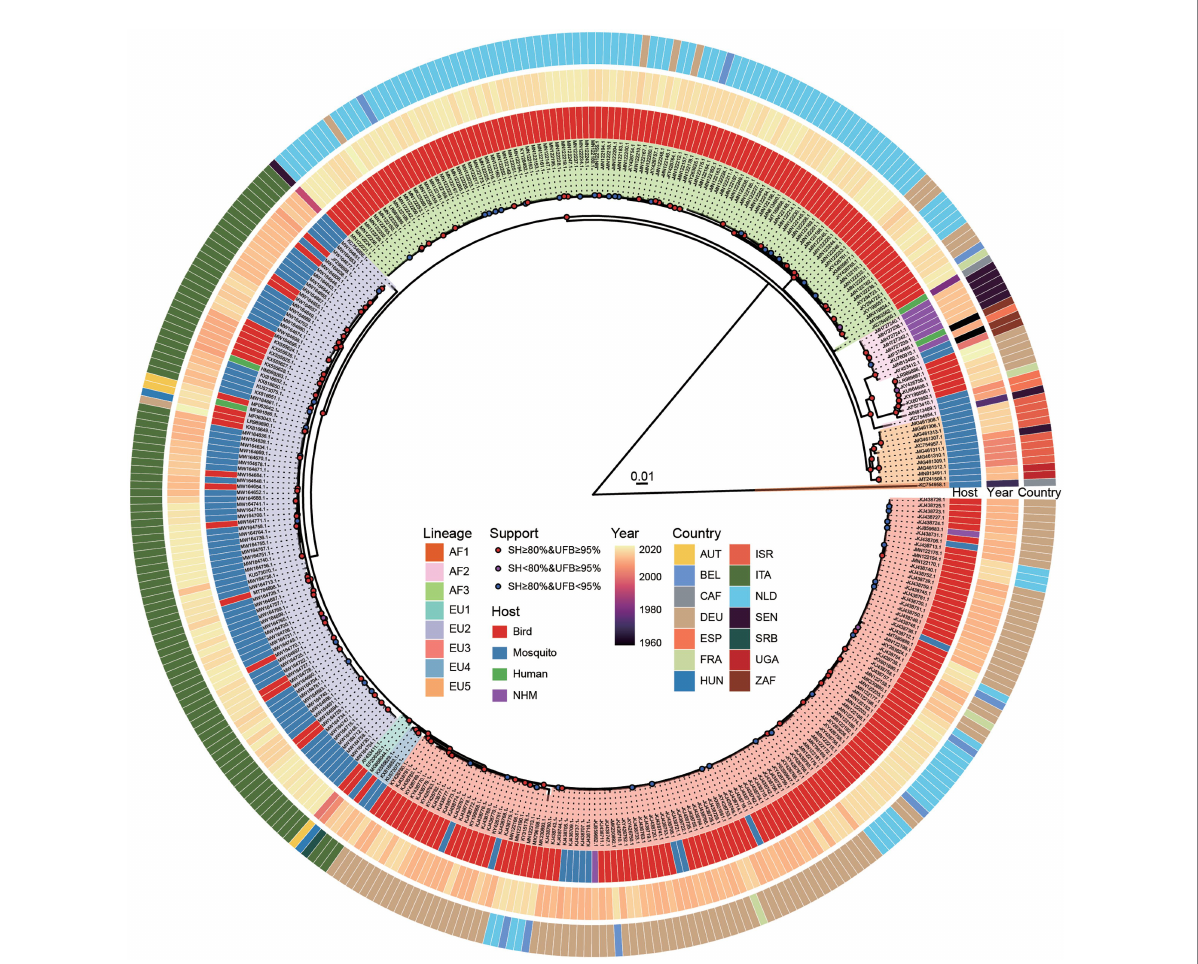
FIGURE 1 Phylogenetic tree of 368 whole genomes of Usutu virus (USUV) based on IQ-TREE. Branch supports were displayed in colored points according to the combination of 1,000 replicates of ultrafast bootstrap (UFB) and SH-aLRT test (SH). The background of the USUV strain labels was filled based on lineage classification. The circular color blocks at the periphery of the tree are distributed from inside to outside indicating the isolation host, collection year, and the country of the isolates,